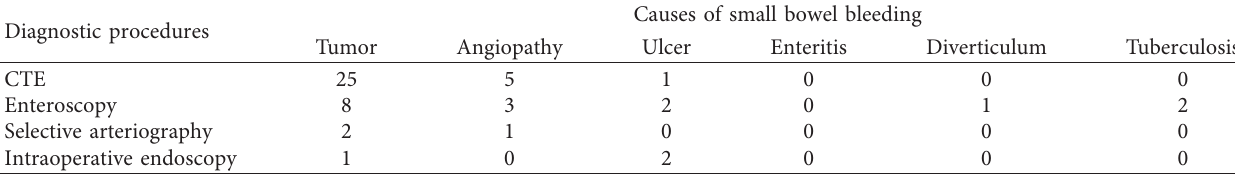
Table 4: Bleeding causes diagnosed by various diagnostic procedures. Diagnostic